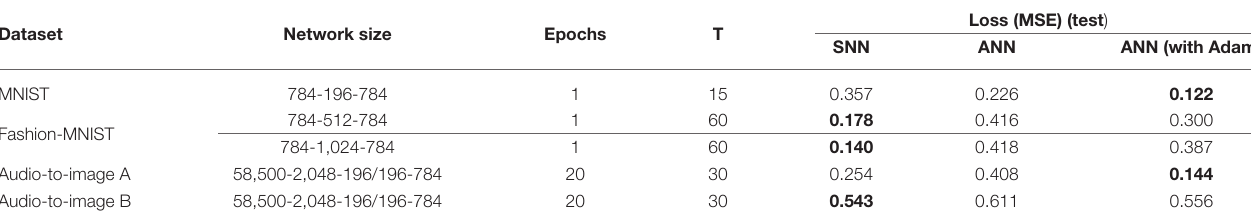
TABLE 1 | Summary of results obtained for the 3 tasks - autoencoder on MNIST, autoencoder on fashion-MNIST, and audio to image conversion (T = input duration for SNN).